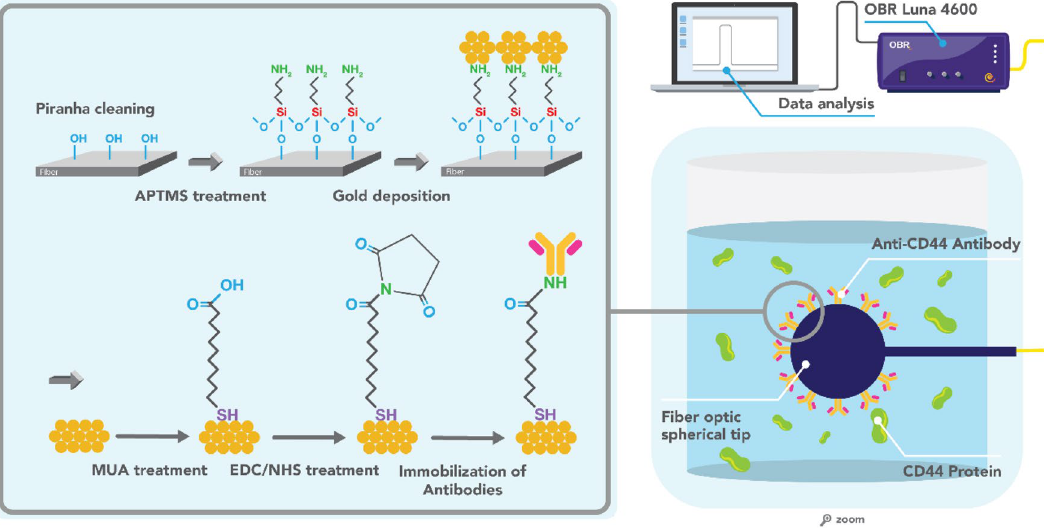
Figure 5. The experimental setup used for the CD44 protein measurements using a fiber optic spherical tip-based biosensor. Surface functionalization steps are shown in the zoomed area. APTMS 3-(aminopropyl) trimethoxysilane, MUA 11-mercaptoundecanoic acid , EDC 1-ethyl-3-(3-dimethylaminopropyl)carbodiimide hydrochloride, NHS N -hydroxysuccinimide, OBR optical backscatter